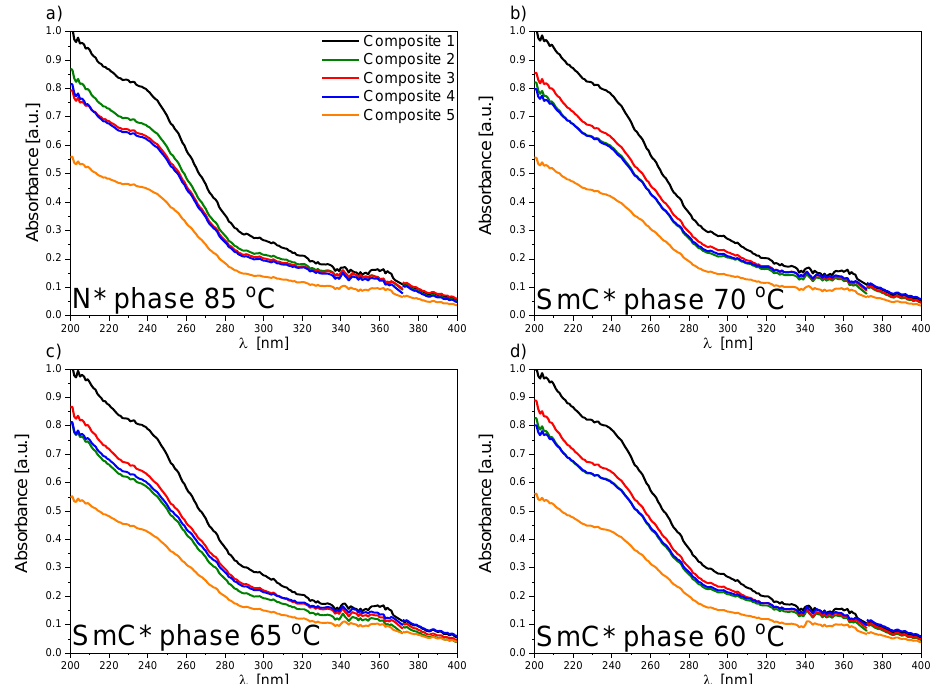
Figure 5. The UV-vis absorption spectra (200–400 nm) for all studied nanocomposites registered during cooling in the N* phase at 85.0 °C ( a ) and the SmC* phase at 70.0 °C ( b ), 65.0 °C ( c ), and 60.0 °C ( d ). The legend in graph ( a ) is the same for all graphs.